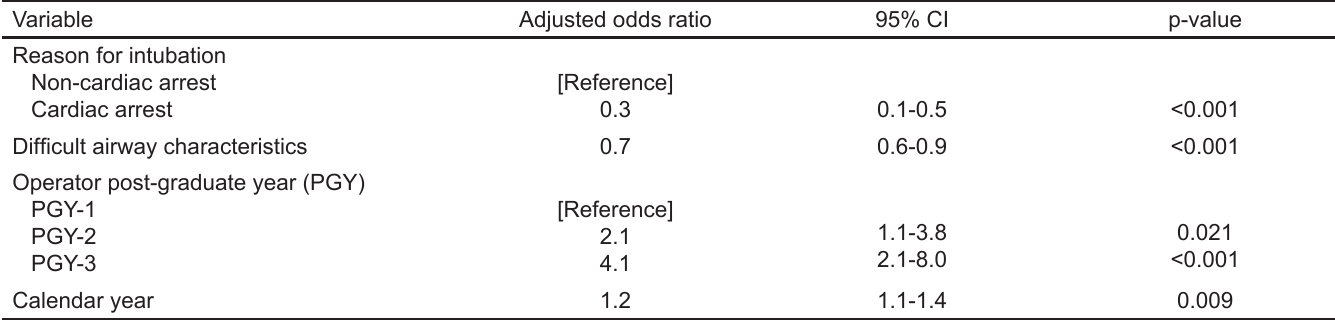
DL, direct laryngoscopy; PGY, post-graduate year Table 2b. Mixed-effects model for improvement in first pass success with GVL.